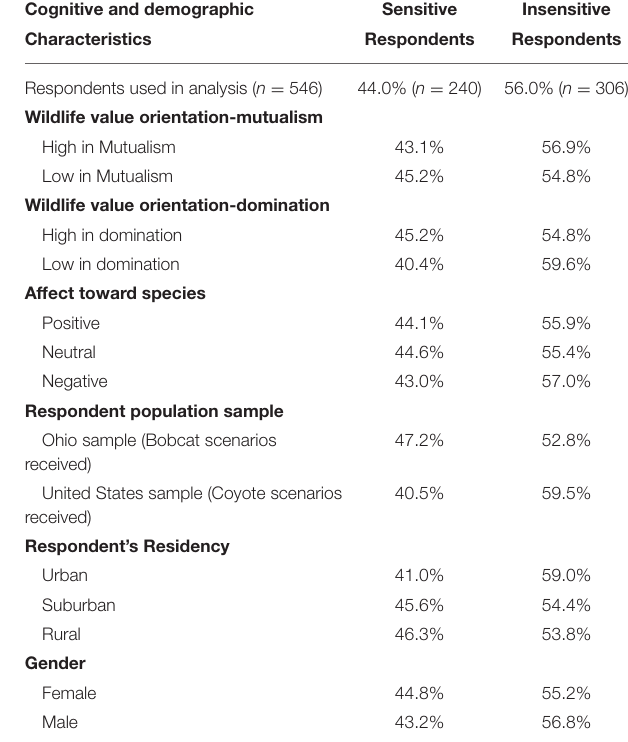
Table 2A | Proportions of contextually sensitive and insensitive responses among various cognitive and demographic sub-groups. Cognitive and